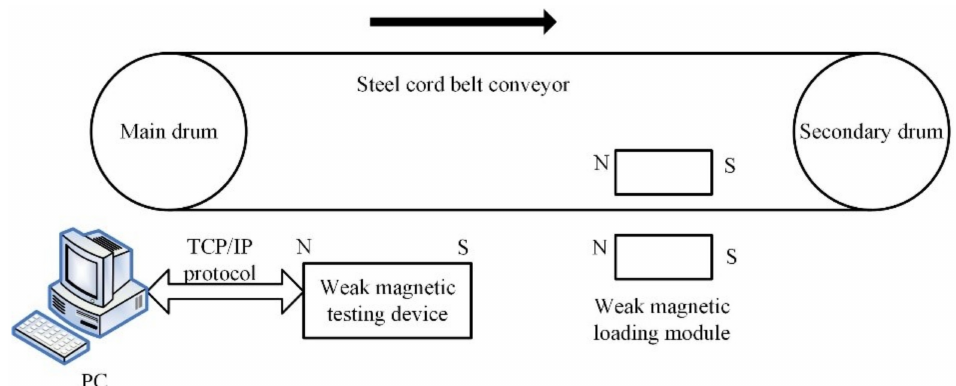
Figure 8. Scheme of the weak magnetic signals collection experiment platform.